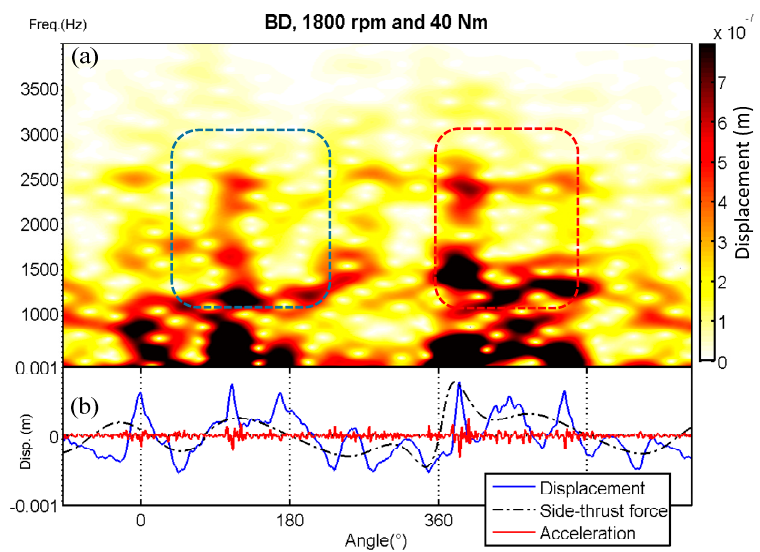
Figure 14. The Short-time Fourier transform (STFT) of dynamic responses to piston slaps of biodiesel; ( a ) STFT result of predicted displacement response; ( b ) Piston side-thrust force, predicted displacement and acceleration responses.